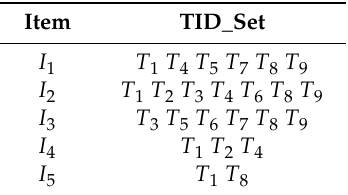
Table 1. A transaction database.